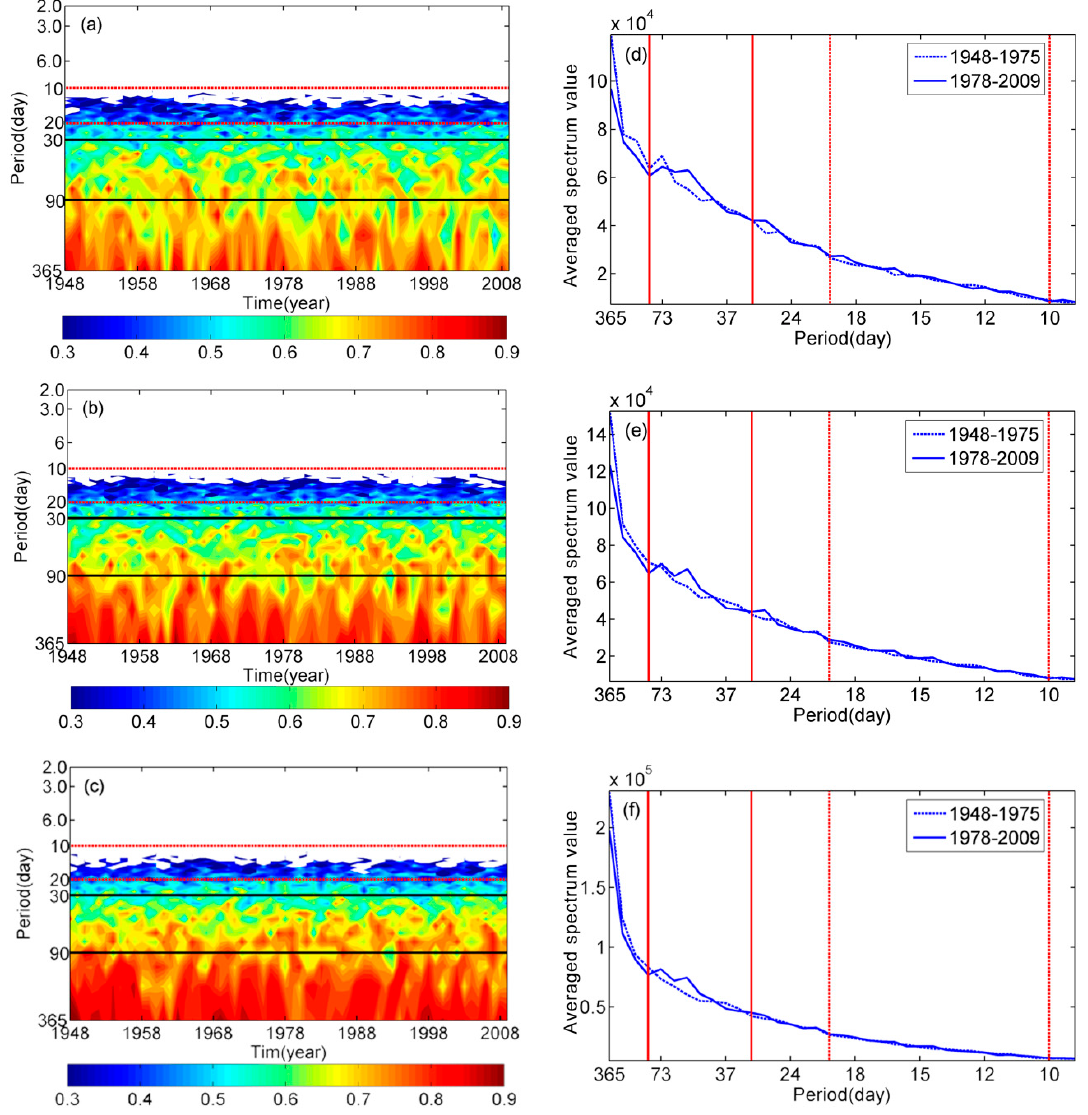
Figure 1. The ratio of global grid numbers whose geopotential height exceeds the 95% confidence level for different temporal bands at the ( a ) 850 hPa level; ( b ) 500 hPa level; and ( c ) 200 hPa level, respectively. The averaged spectrum values for the two sub-periods 1948–1975 and 1978–2009 at the ( d ) 850 hPa level; ( e ) 500 hPa level; and ( f ) 200 hPa level, respectively. The black solid lines in ( a – c ) and red solid lines in ( d – f ) denote the intra seasonal oscillation (ISO) band. The red dotted lines in ( a – f ) denote the quasi-biweekly oscillation (QBWO) band.